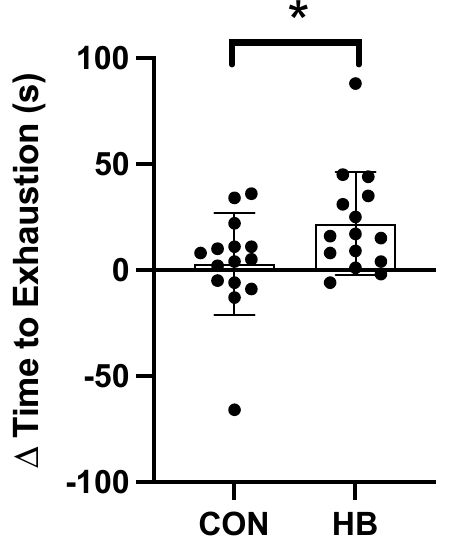
. V O 2peak test in the placebo control